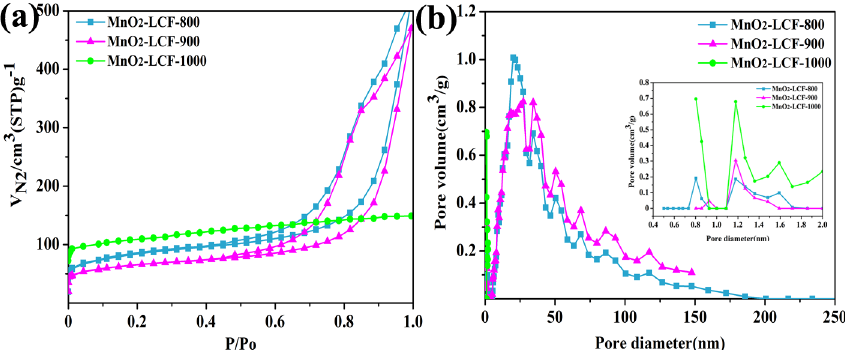
Figure 4. N 2 adsorption/desorption isotherms of the MnO 2 -LCF samples ( a ) and the corresponding BJH pore size distributions ( b ). Table 1. Brunauer–Emmett–Teller (BET) analysis of the MnO 2 -LCF